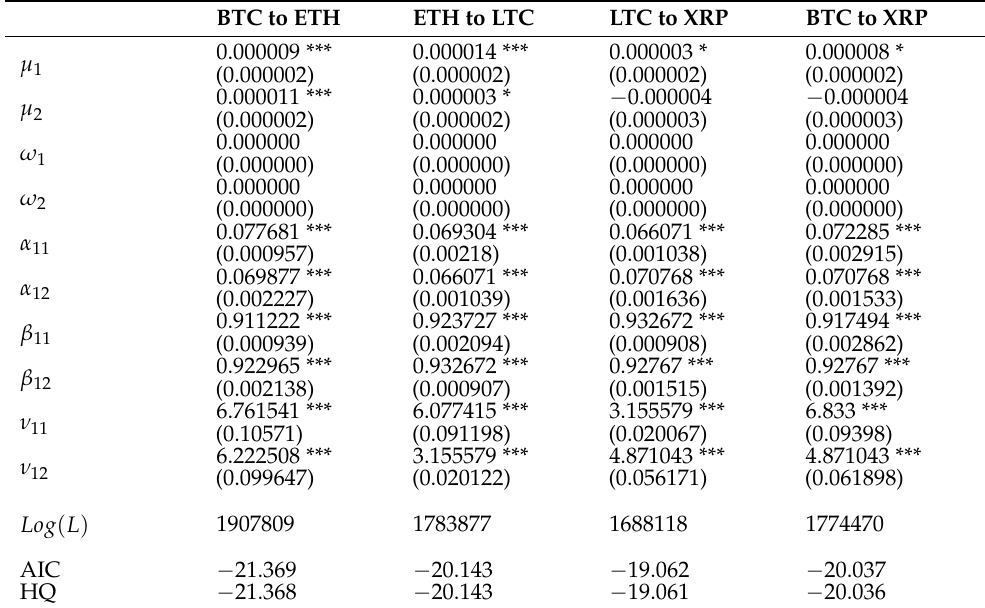
Table 8. DCC-GARCH model